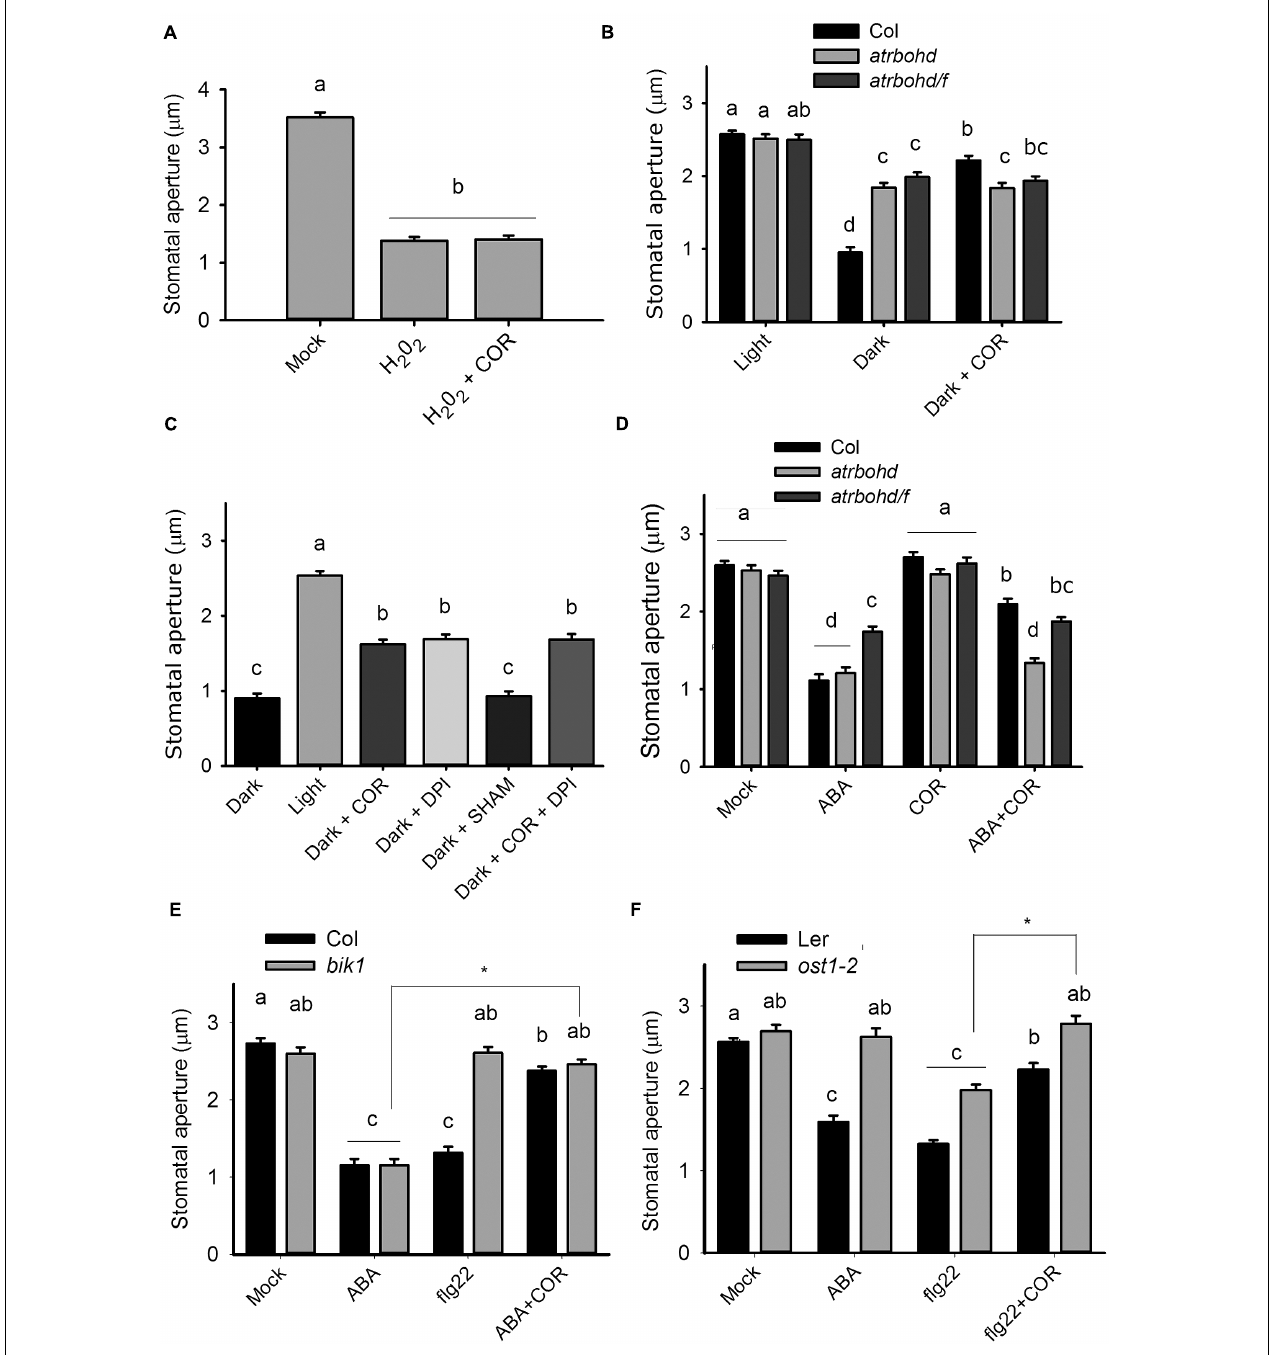
FIGURE 3 | The effect of coronatine on stomatal closure requires ROS production by NADPH oxidases but does not depend on OST1 and BIK1 kinases. (A) Coronatine (COR, 1.56 µ M) could not inhibit stomatal closure induced by H 2 O 2 (100 µ M). Stomatal apertures were measured 1.5 h after application of the respective treatment. (B) atrbohd and atrbohd/f mutants are partially impaired in darkness-induced stomatal closure and coronatine (COR, 1.56 µ M) failed to further inhibit it. (C) Coronatine (COR, 1.56 µ M), DPI (20 µ M) but not SHAM (2 mM) inhibited darkness-induced stomatal closure (D) Coronatine (COR, 1.56 µ M) failed to inhibit promotion of closure by ABA (20 µ M) in atrbohd and atrbohd / f mutants but not in Col. (E) bik1 mutant is sensitive to coronatine (COR, 1.56 µ M) for ABA-induced stomatal closure. (F) ost1-2 mutant is sensitive to coronatine (COR, 1.56 µ M) for flg22-induced stomatal closure. In (B , C) coronatine, DPI or SHAM were added at the beginning of the incubation with buffer 10/10 for 2 h. In (A) and (D–F) coronatine was added 10 min before the respective treatments. Different letters indicate significant differences at p < 0.05 in (B) and (D–F ; two-way ANOVA) and (A,C ; one-way ANOVA, Tukey’s test). Datasets marked with asterisks are significantly different as assessed by ANOVA test, ∗ p < 0.05. Error bars represent SE from two (A,B) and (D–F) or three (C) independent trials, n = 40 per trial in all experiments.